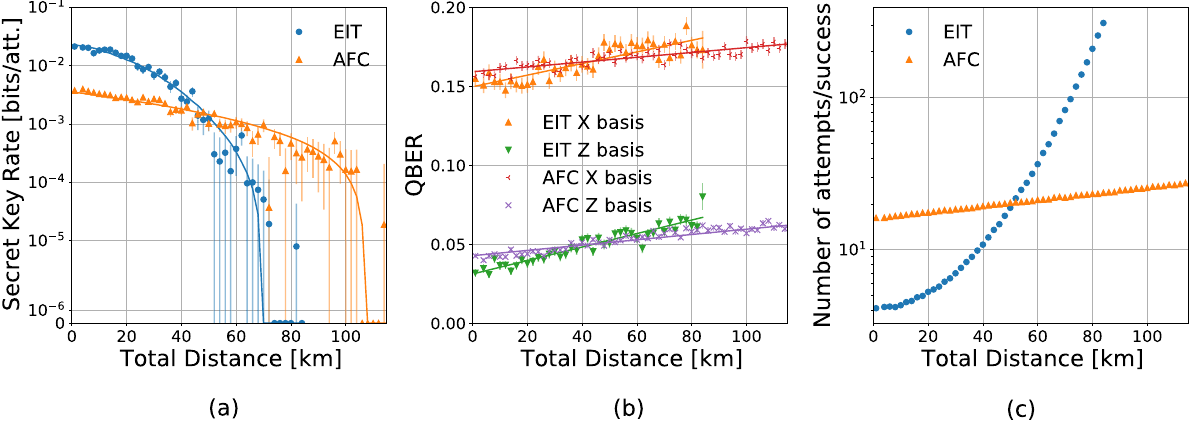
Fig. 7 Performance comparison of a single quantum repeater with atomic frequency comb (AFC) or electronically induced transparency (EIT) quantum memories. Shown are: ( a ) the secret key rate in secret bits per entanglement generation attempt, ( b ) the quantum bit error rate (QBER) in the X and Z bases ( c ) the average number of attempts necessary for one successful end-to-end entanglement generation. Each data point is obtained using 10.000 (EIT) or 30.000 (AFC) successful attempts at generating entanglement between the end nodes. Solid lines are fi ts. Note that for the secret key plot we use logarithmic scale with added 0 at the origin of the axes. Error bars denote standard deviation and are symmetrical.